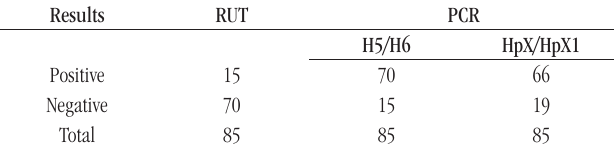
taBLE 2 − Results from RUT and molecular diagnosis (PCR) for genes